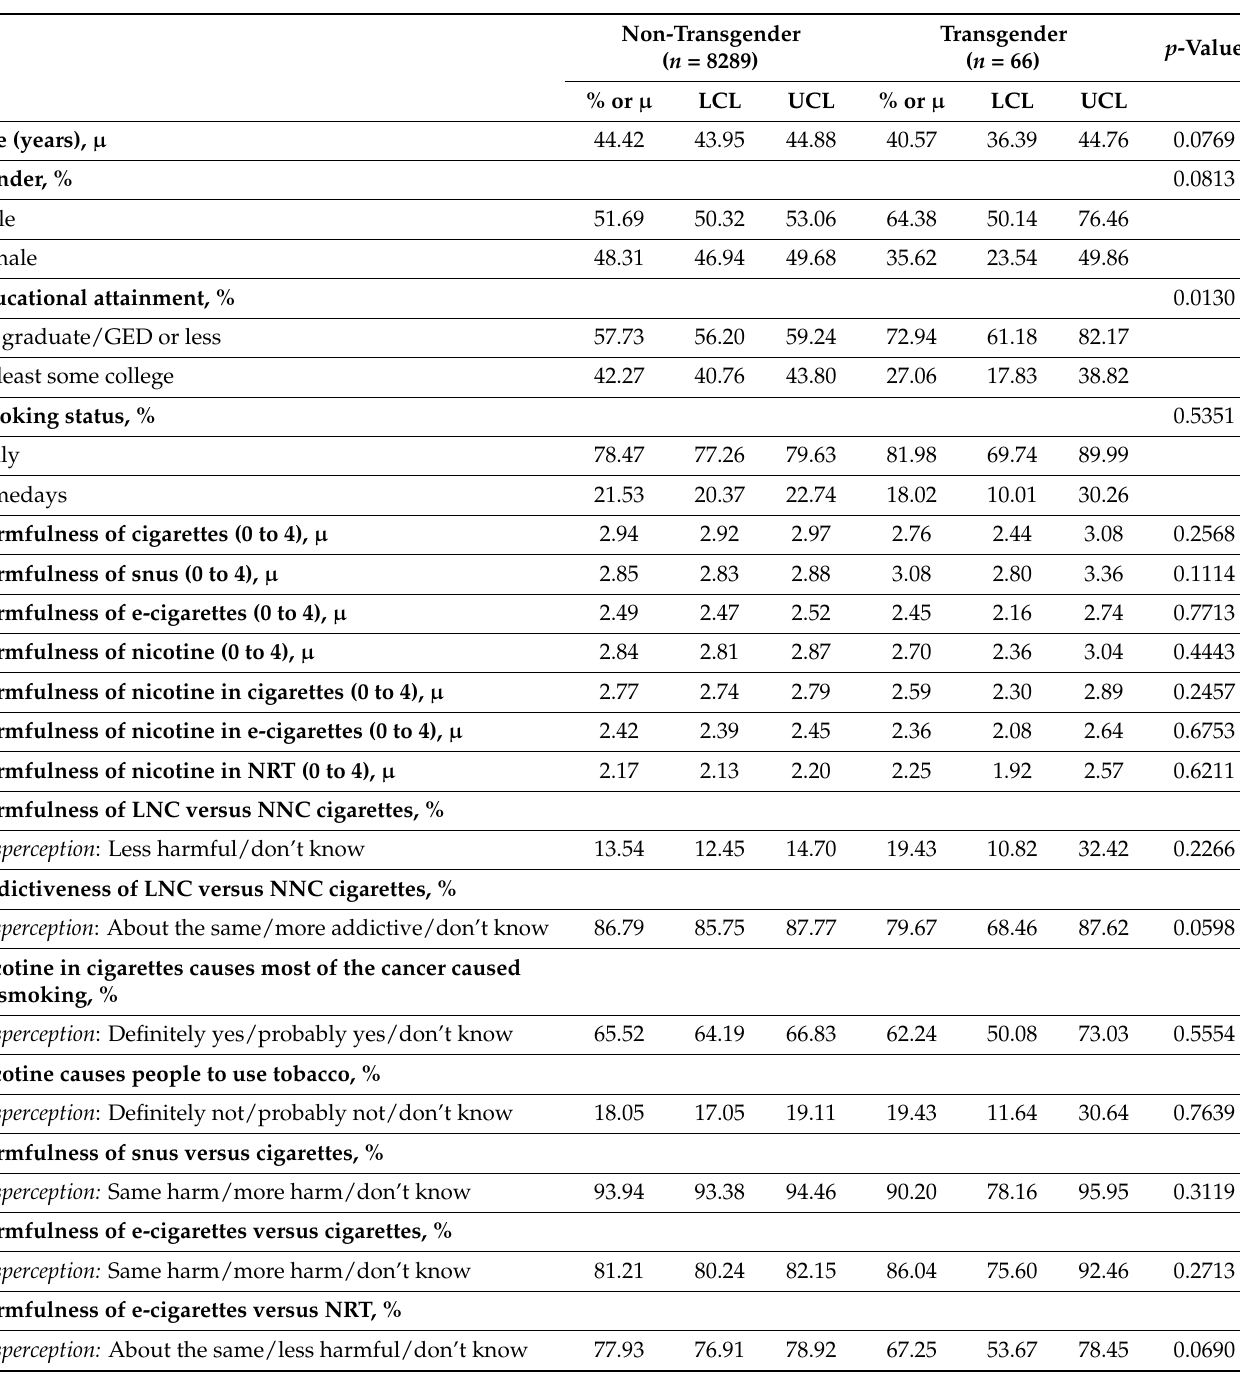
Table 3. Weighted mean values or weighted proportions and corresponding 95% confidence intervals; PATH Wave 4 adults; Current established daily or someday smokers who are not established users of non-combustible products by transgender